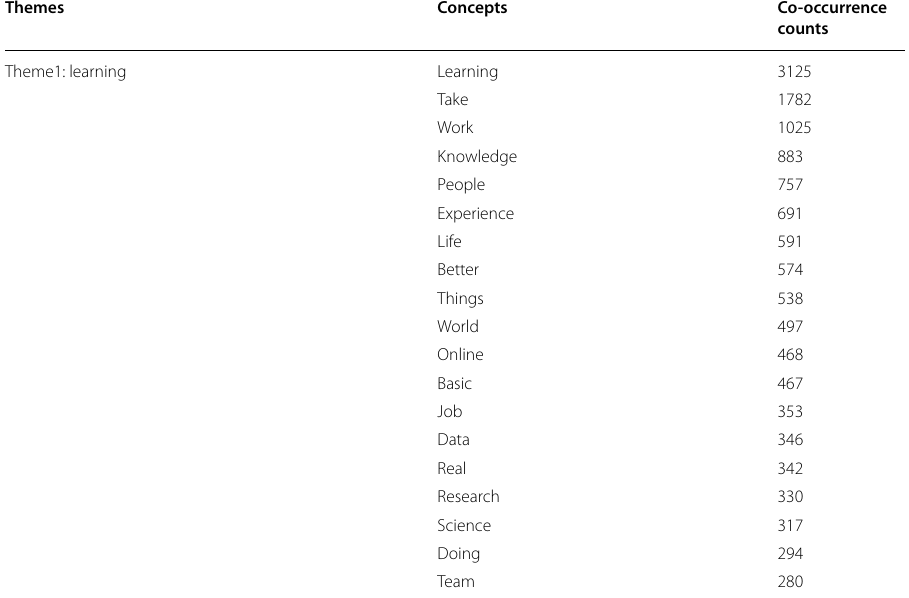
Table 7 Text co-occurrence counts of a concept with every other concept on the thematic map